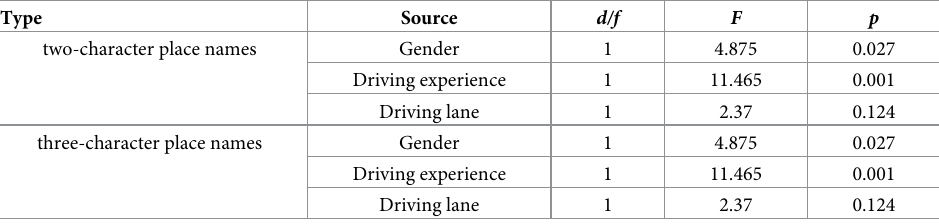
Table 9. Single-factor analysis of variance results of drivers’ recognition reaction time of exit warning